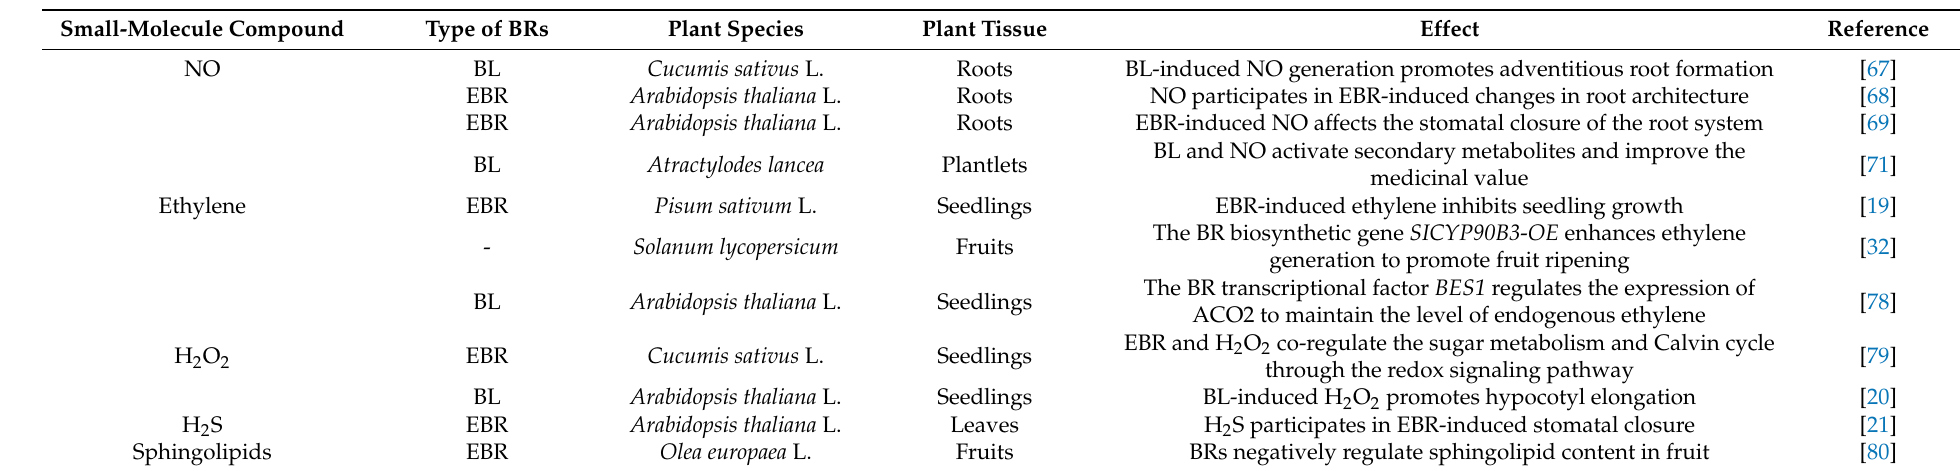
Table 2. The roles of BRs and small-molecule compounds in plant growth and